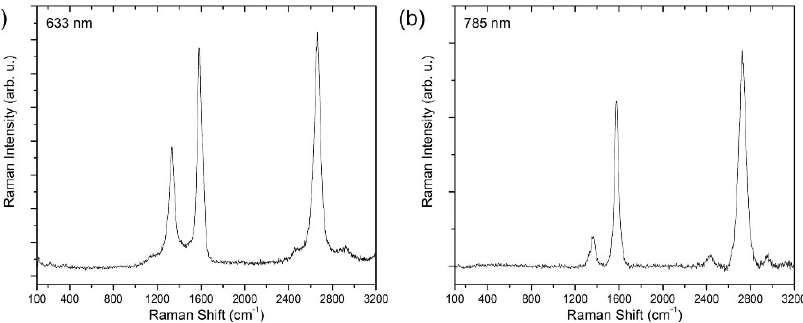
Figure 4. Resonant Raman spectroscopy of MWCNTs was recorded using ( a ) 633 nm and ( b ) 785 nm lasers.